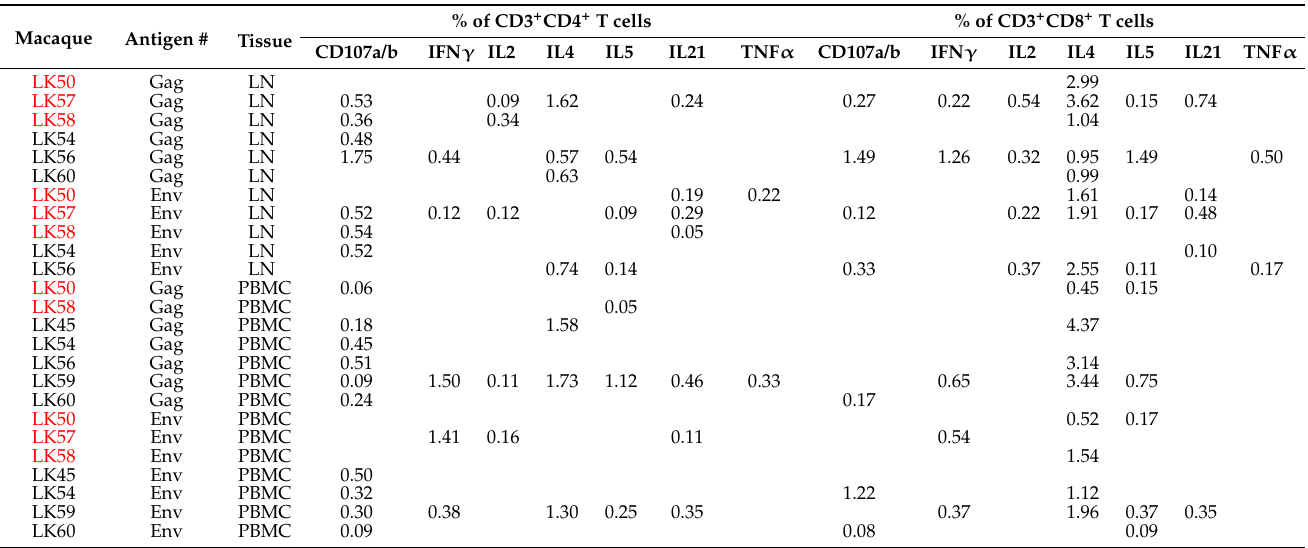
Table 1. SIV antigen-specific cytokine responses in LN and PBMC from vaccinated macaques at pV#5 time